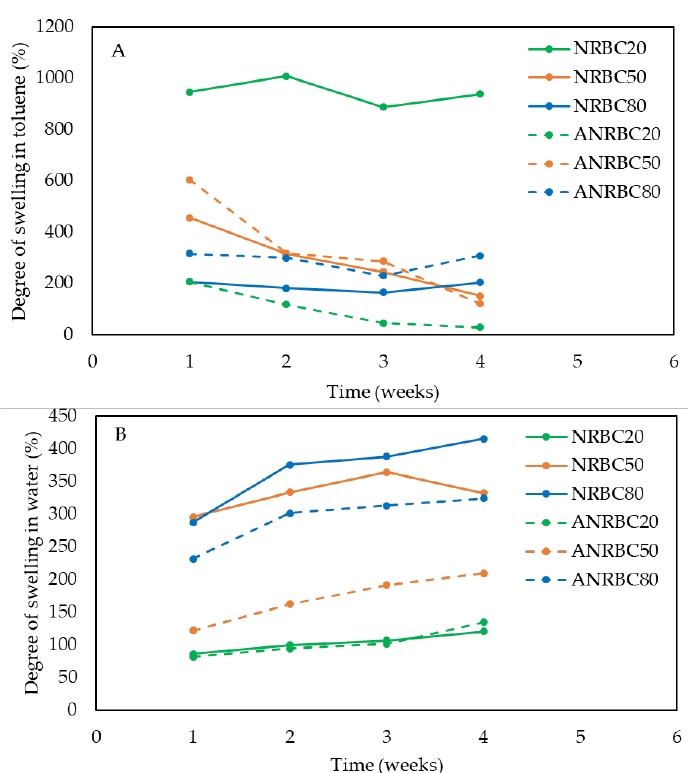
Figure 8. Degree of swelling of NRBC and ANRBC films in toluene ( A ) and water ( B ).